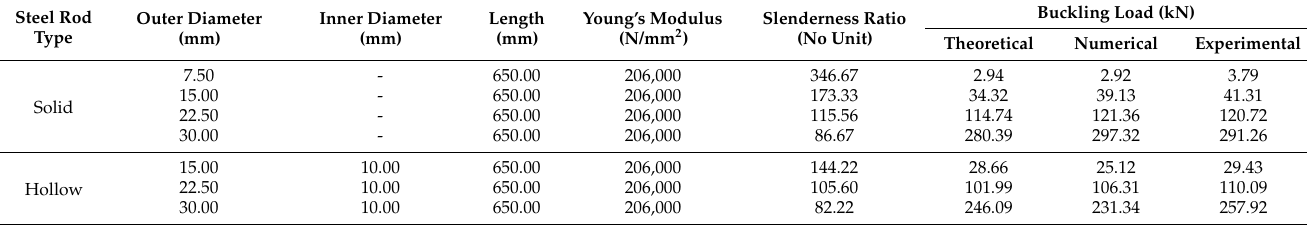
hybrid rods. The inner diameter for hollow steel rods was determined to be 10 mm. Table 4. Theoretical, numerical and experimental results of steel (only)